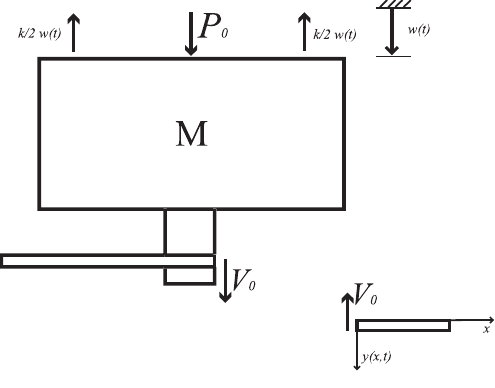
Fig. 3. Freebody diagram of the